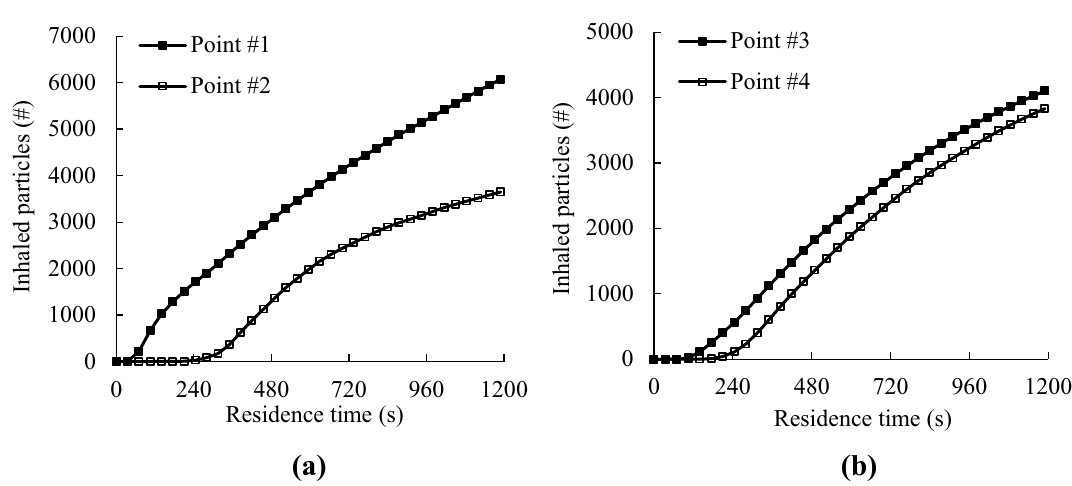
Figure 9. Averaged inhaled particle numbers for different residence times after flushing of the toilet when no face mask was worn: ( a ) at point #1 (0.4 m, 0.15 m, 1 m) and point #2 (0.4 m, 0.15 m, 1.5 m), ( b ) at point #3 (0.7 m, 0, 1 m) and point #4 (0.7 m, 0, 1.5